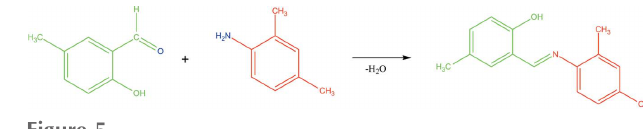
Figure 5 The scheme of synthesis of the title compound.